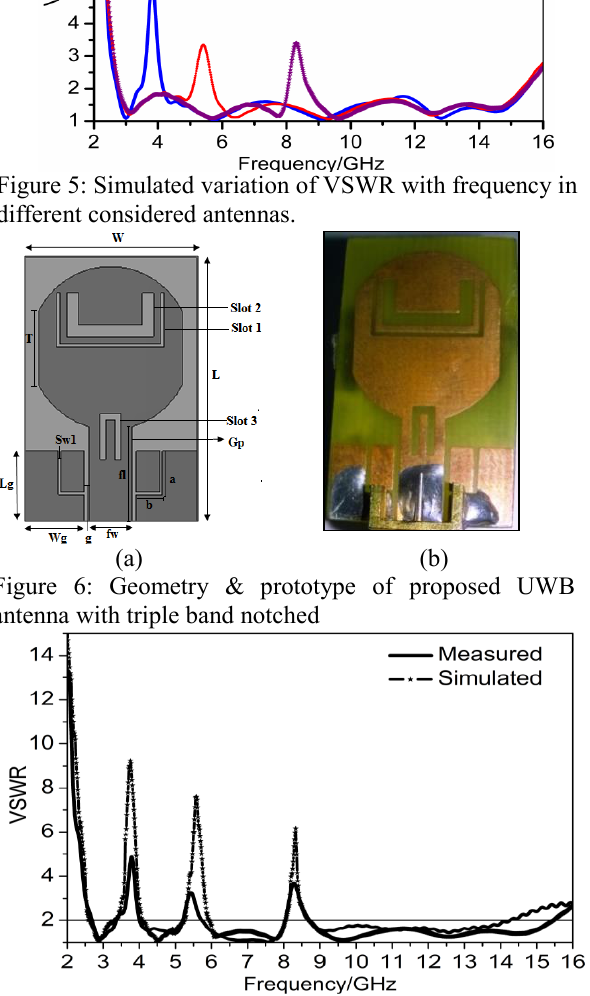
Figure 7: Variation of measured/simulated VSWR of the proposed UWB antenna